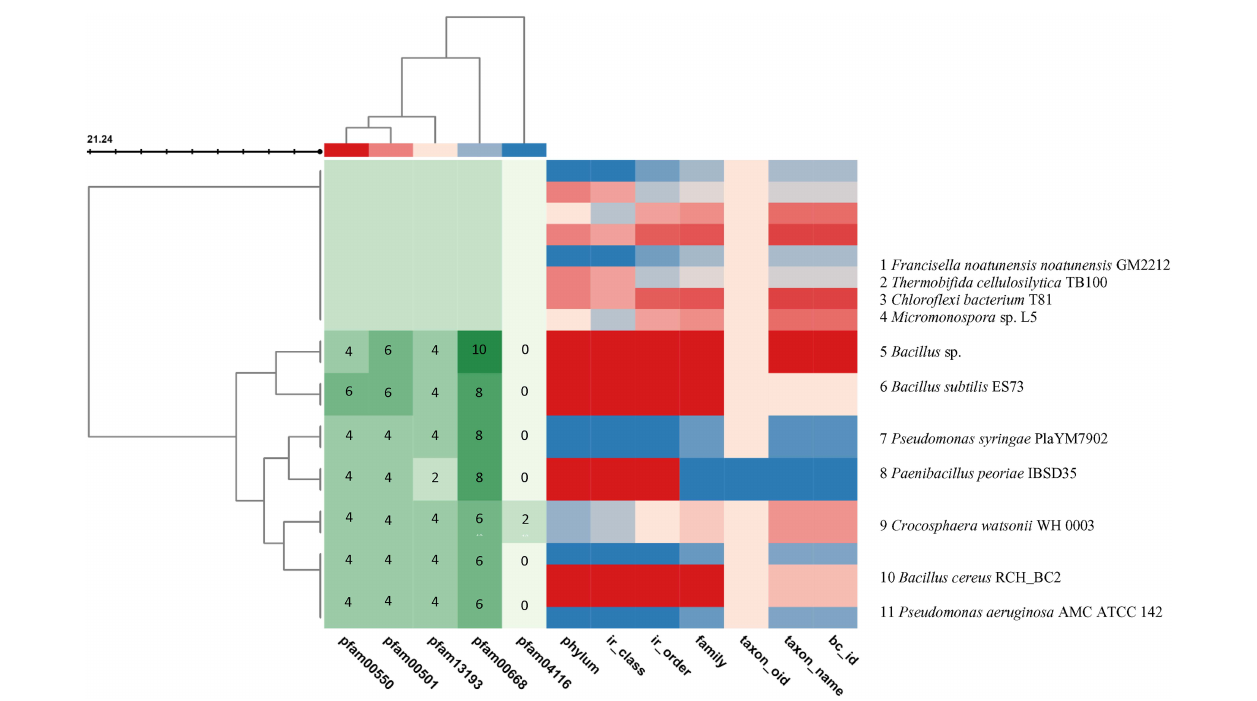
FIGURE 5 | Visualization of the BGCs plotted in color code from the selected 11 genomes using the JGI/ABC database. The color code is represented in numbers to indicate the number of pfam counts using MS Word. The X axis indicates the pfam and the genome taxonomy. The genomes are indicated at the right Y axis. The left branching indicates the phylogeny relation of the BGCs. The BC similarity search was based on pre-calculated pairwise similarity scores using the Jaccard Index statistic for comparing two sets. The core genes are pfam00501: AMP-binding enzyme, pfam00550: phosphopantetheine attachment site, pfam00668: condensation domain, pfam04116: fatty acid hydroxylase superfamily. The list of genomes from the JGI/ABC database include: 1, Francisella noatunensis noatunensis GM2212; 2, Thermobifida cellulosilytica TB100; 3, Chloroflexi bacterium T81; 4, Micromonospora sp. L5; 5, Bacillus sp.; 6, Bacillus subtilis ES73; 7, Pseudomonas syringae PlaYM7902; 8, Paenibacillus peoriae IBSD35; 9, Crocosphaera watsonii WH 0003; 10, Bacillus cereus RCH_BC2; and 11, Pseudomonas aeruginosa AMC ATCC 142. (Two scores are calculated: Jaccard Score: fraction of distinct pfams shared between two BCs (intersection) over the total number of distinct pfams in both sets (union). Adjusted Jaccard Score: a modified version of the Jaccard Score that considers the similarity between the number of occurrences of each pfam in each